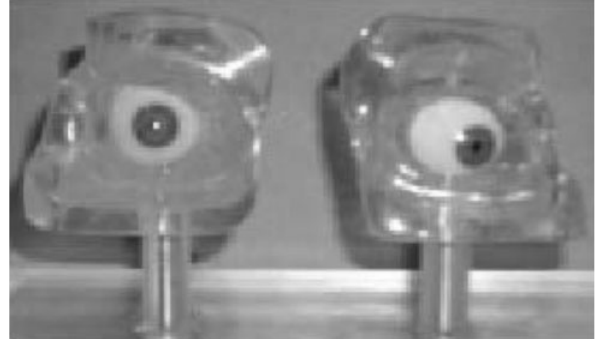
Figure 10 Artificial eye model.